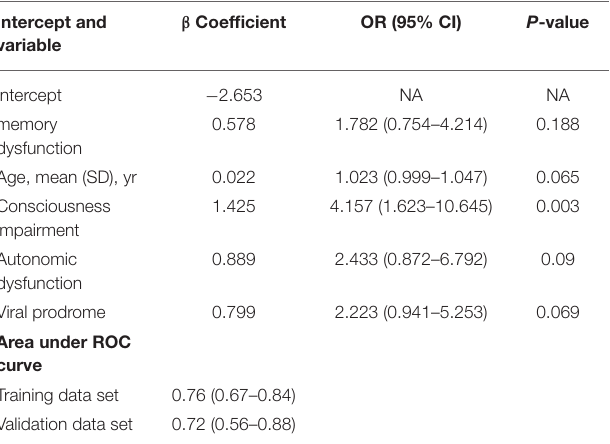
TABLE 3 | Predictors for poor prognosis in final regression model for training data set.